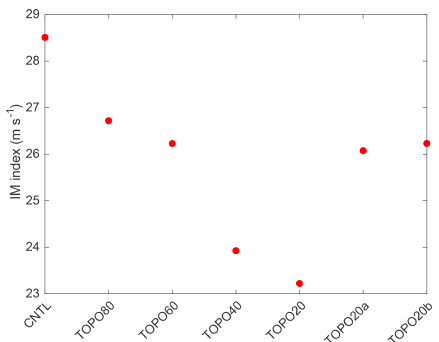
Figure 7. Indian summer monsoon (June–July–August) index, WSI1, calculated as the vertical wind shear between the lower (850hPa) and upper (200hPa) troposphere in the region (5–20 ◦ N, 40–80 ◦